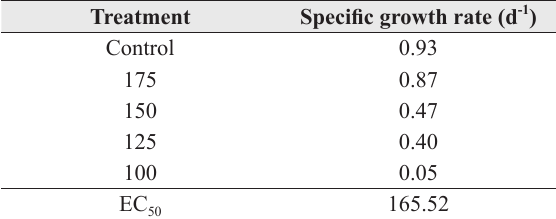
Specific growth rate (d -1 ) and EC quadricauda grown at different effluent concentrations.